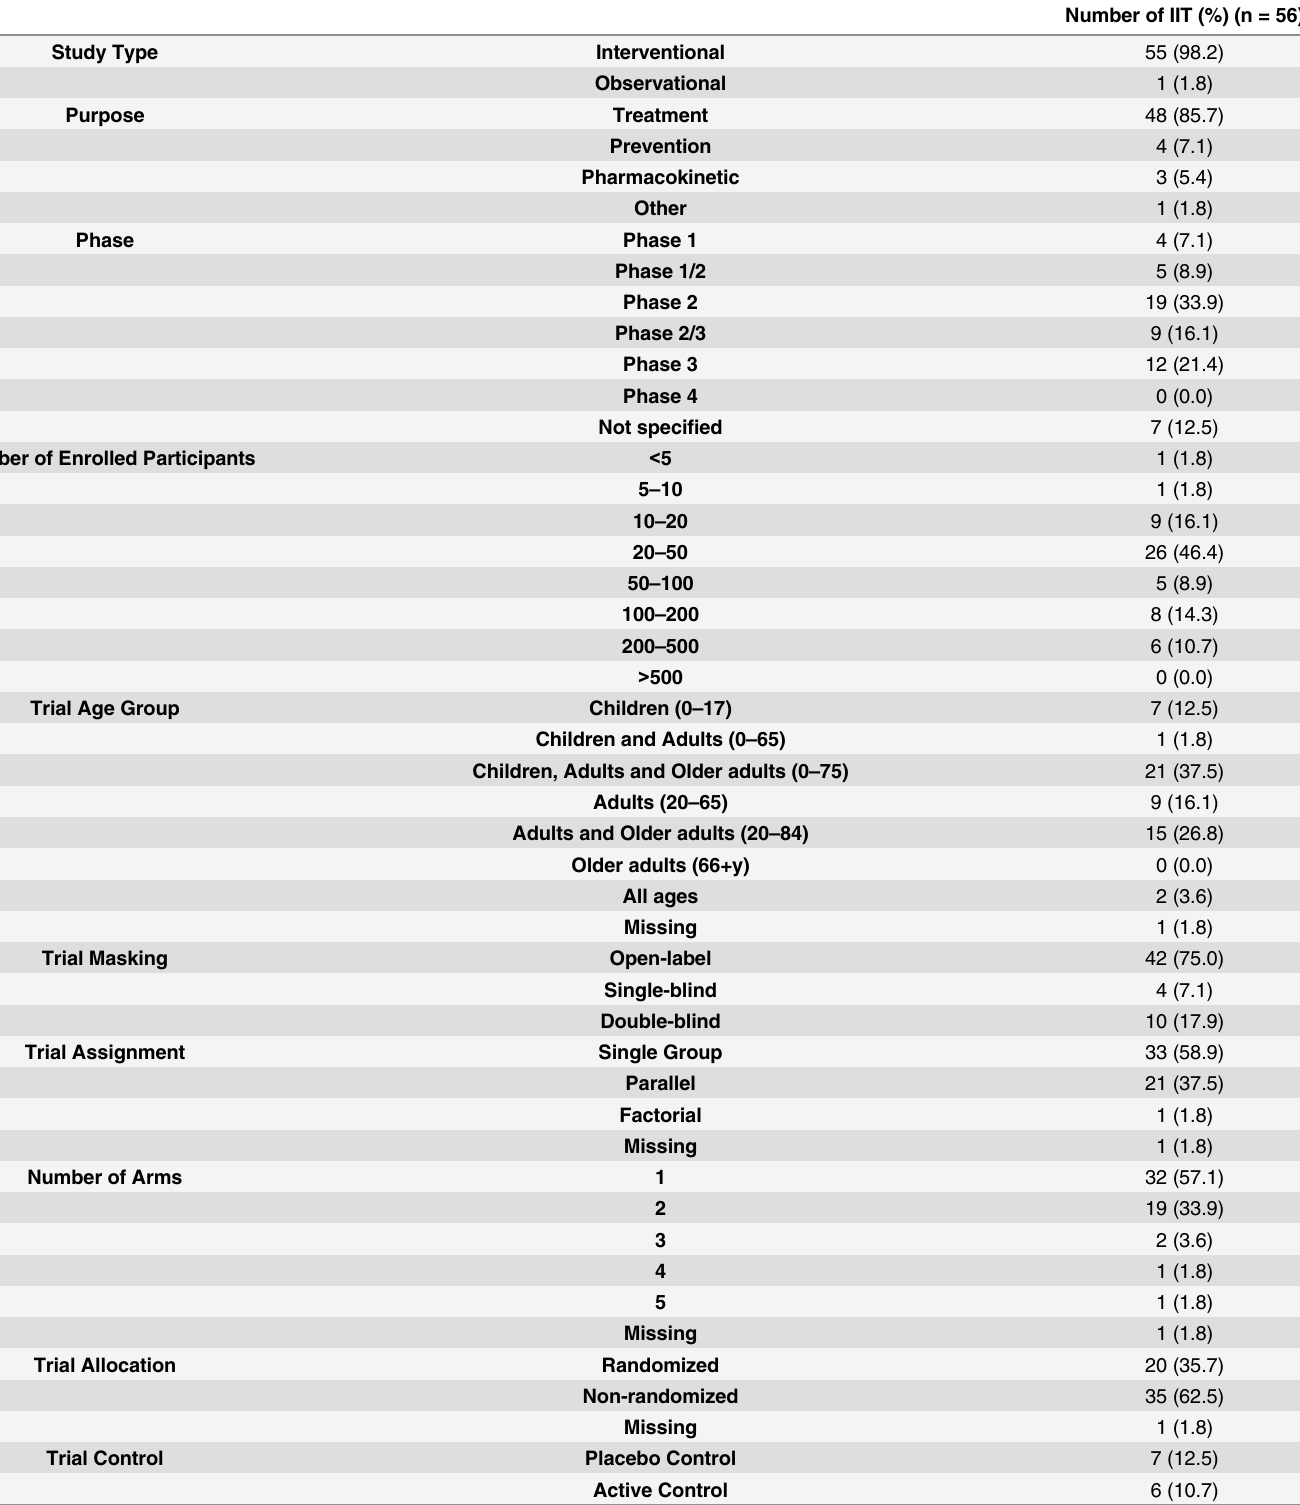
Table 3. Characteristics of Investigator Initiated Trials Registered in Japan from 2004 to